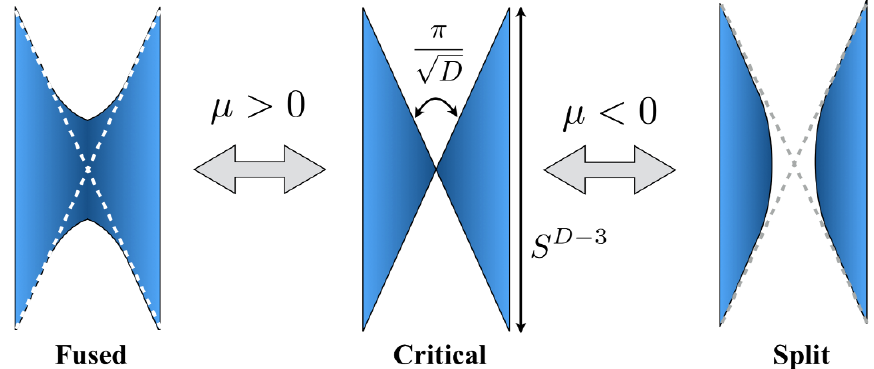
Figure 1 . Topology change across the black string/black hole transition, as (cid:12)rst proposed in [11]. (cid:22) is the parameter in the solutions that changes sign across the transition.